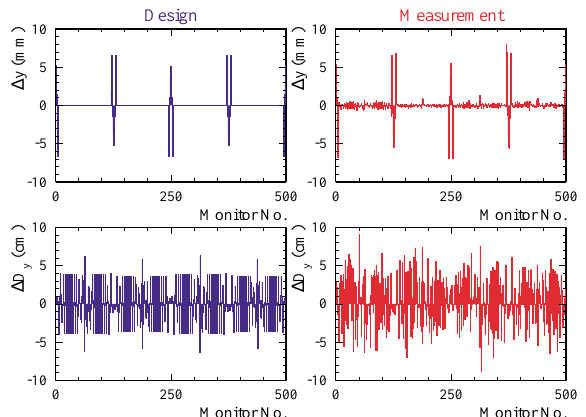
FIG. 8. (Color) Design (left) and measured (right) vertical orbit difference D y and dispersion difference D D y between the e 1 and e 2 beam. The four separation bumps are clearly visible on the closed orbit difference. The measured rms orbit difference outside the separation bumps is 0.2 mm. The residual vertical dispersion difference of 3.1 cm is generated by the separation bumps. This corresponds to a dispersion of 1.5 cm for each beam, but of opposite sign for e 1 and e 2 .